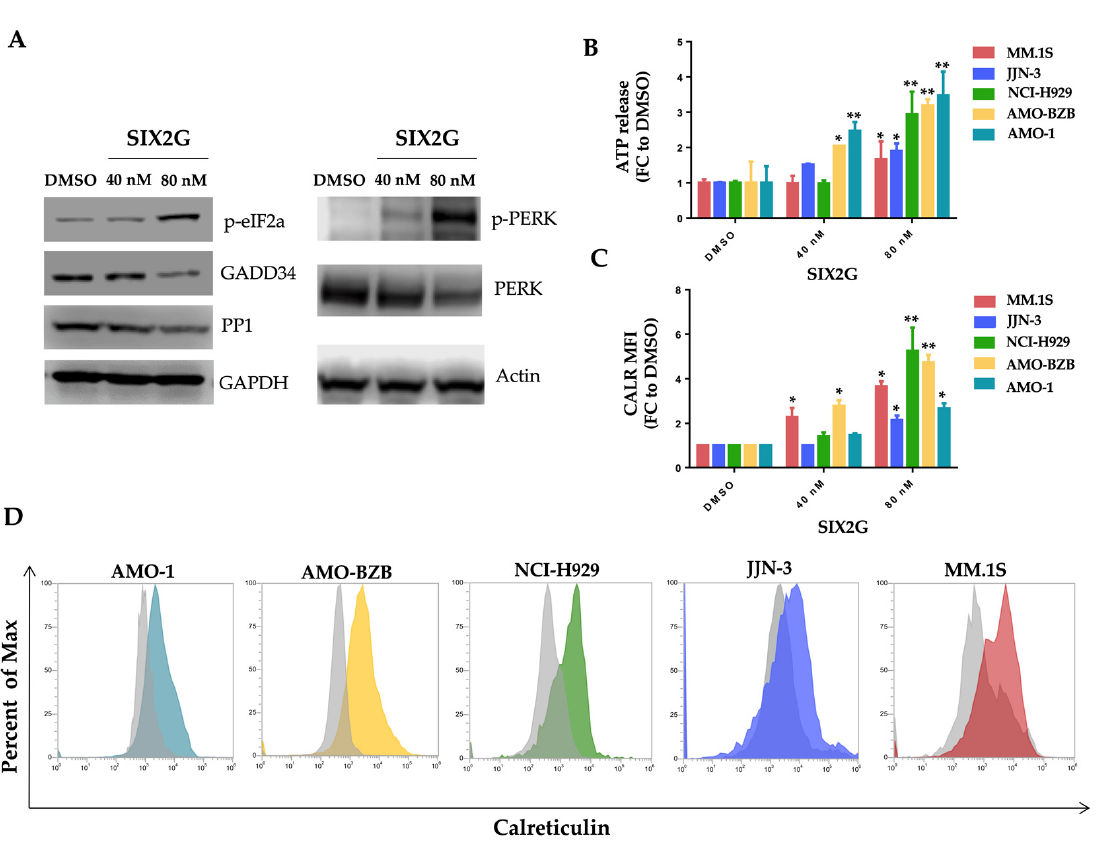
Figure 6. Assessment of the onset of ICD. Representative WB analysis of PP1, GADD34, phosphorylated-eIF2 α (p-eIF2 α ), PERK and phosphorylated-PERK (p-PERK) conducted on AMO-1 cells, 48 h after treatment with SIX2G. GAPDH or Actin were used as loading controls ( A ). The release of ATP in cell supernatant was detected through a Cell Titer Glo ® Assay. Histogram bars represent mean ± SD of the FC of absorbance values from cells treated with SIX2G respect to cells treated with DMSO ( B ). CALR exposure to the cell membrane was evaluated through flow cytometry. Histogram bars represent mean ± SD of FCs of median fluorescence intensity (MFI) values of CALR signal in cells treated with SIX2G respect to DMSO ( C ). Representative images of flow cytometric analyses of CALR membrane exposure 48 h after treatment with SIX2G at 80 nM (colored curves) or DMSO (gray curves) are reported ( D ). Student’s t -test was applied to calculate the statistical significance between multiple group comparisons, respect than DMSO treated cells. p -value < 0.05 is indicated with one star (*), p -value < 0.01 with two stars